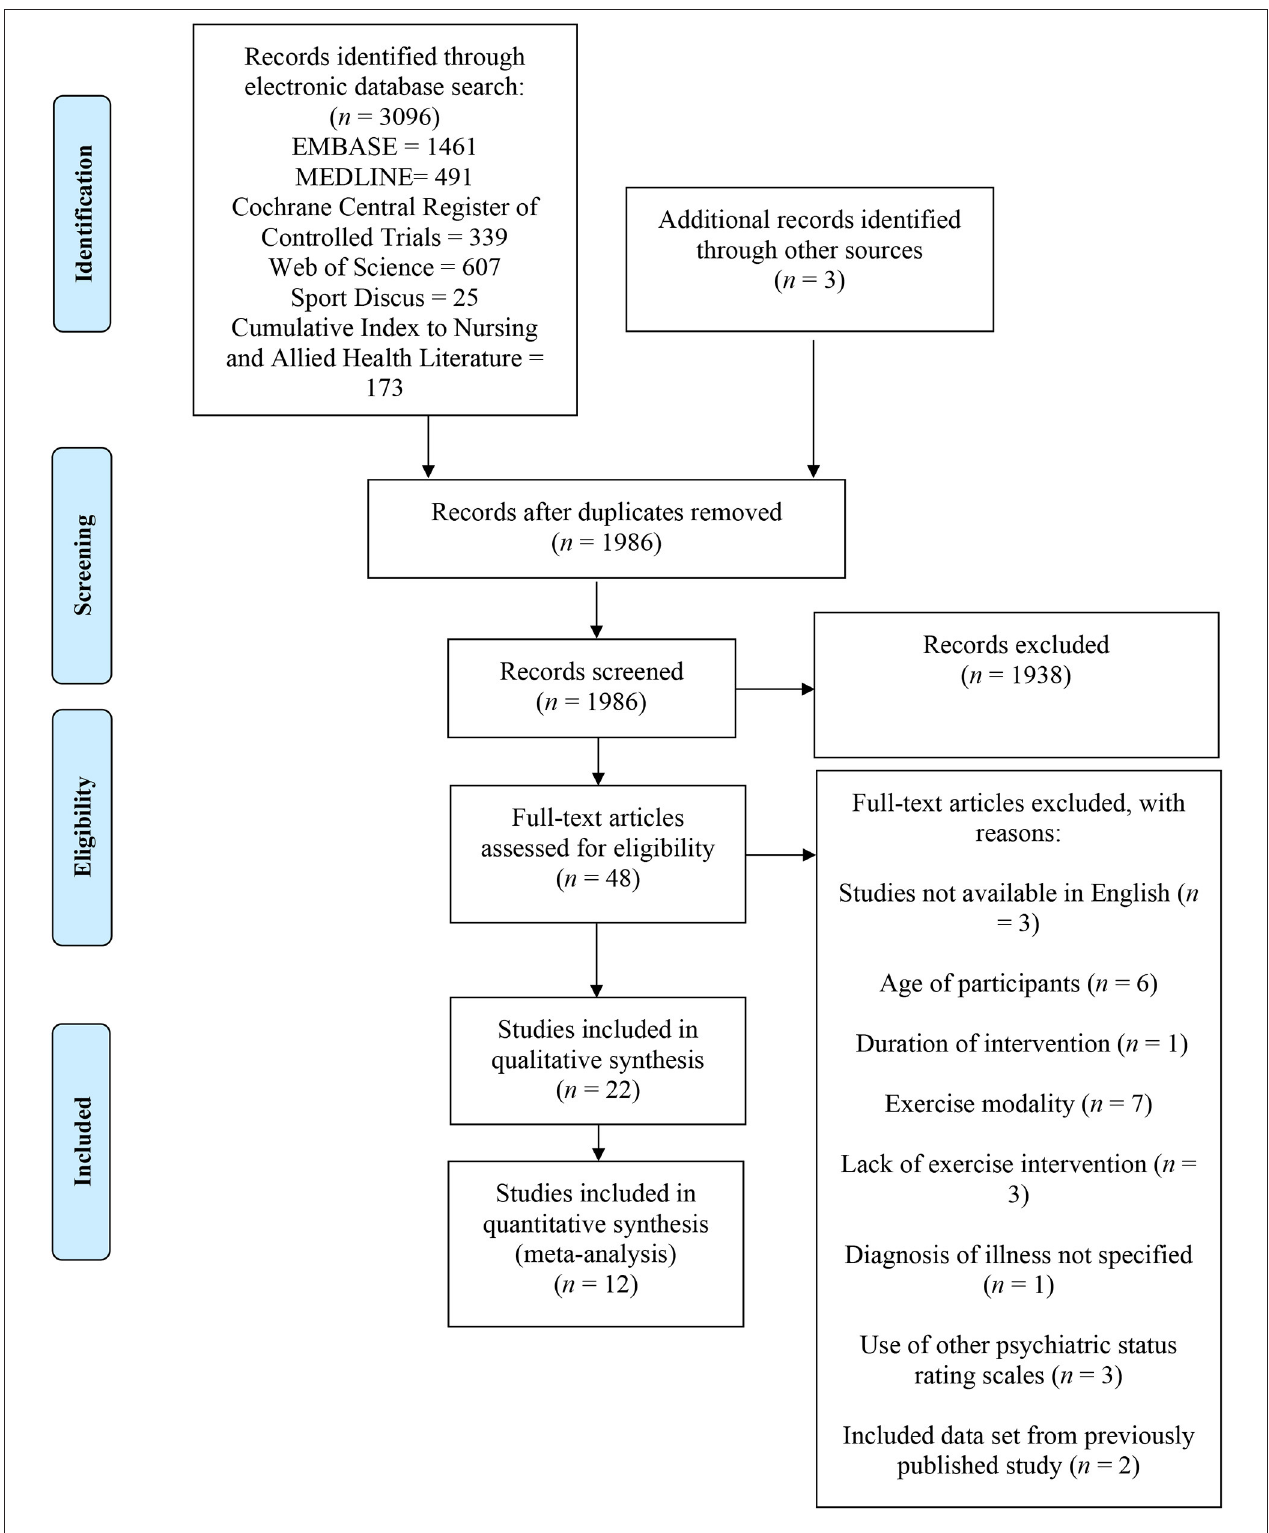
FIGURE 1 | Results of the systematic